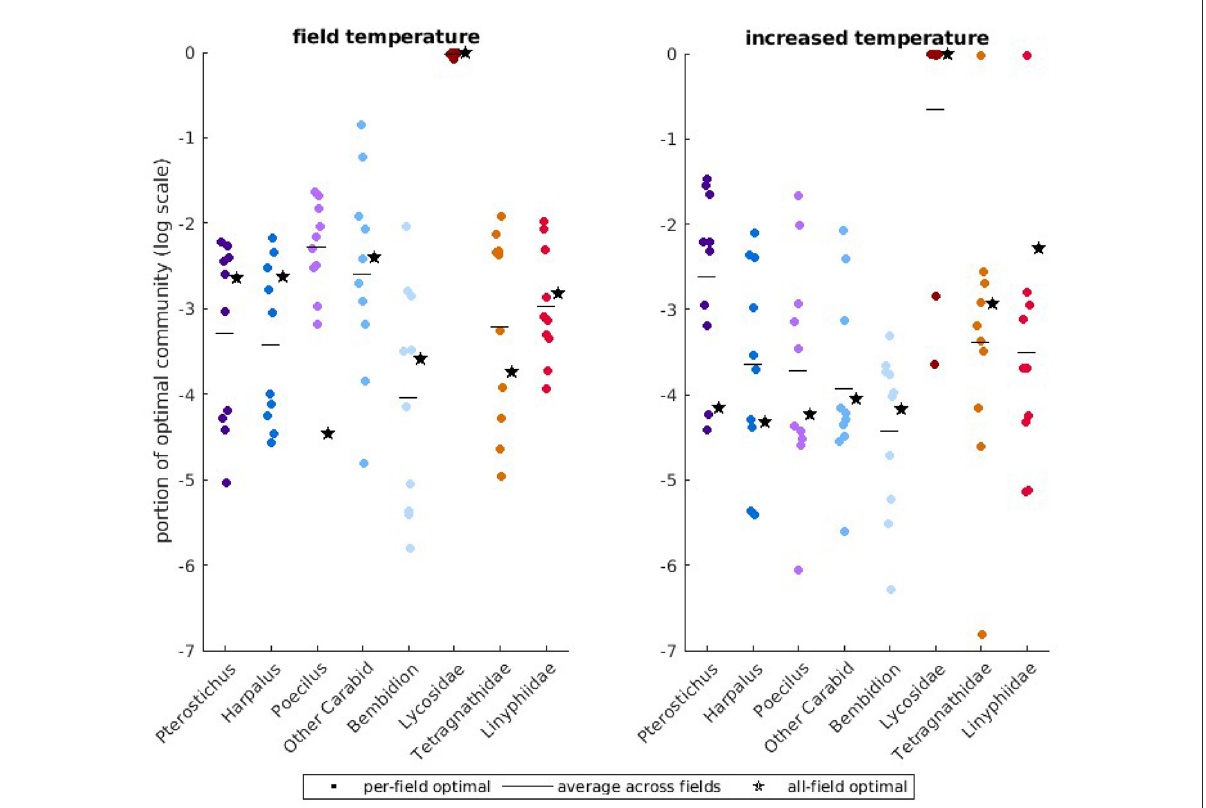
FIGURE3 Portion of optimal predator communities plotted on a logarithmic scale for field temperatures and higher, more variable temperatures. In the (left) , we show optimal predator communities at field temperatures and in the (right) , we show the optimal predator communities at higher temperatures. Each dot denotes the optimal predator biomass for one field. The horizontal line for each predator indicates the average optimal biomass over all fields. The star marker indicates the optimal biomass over all fields